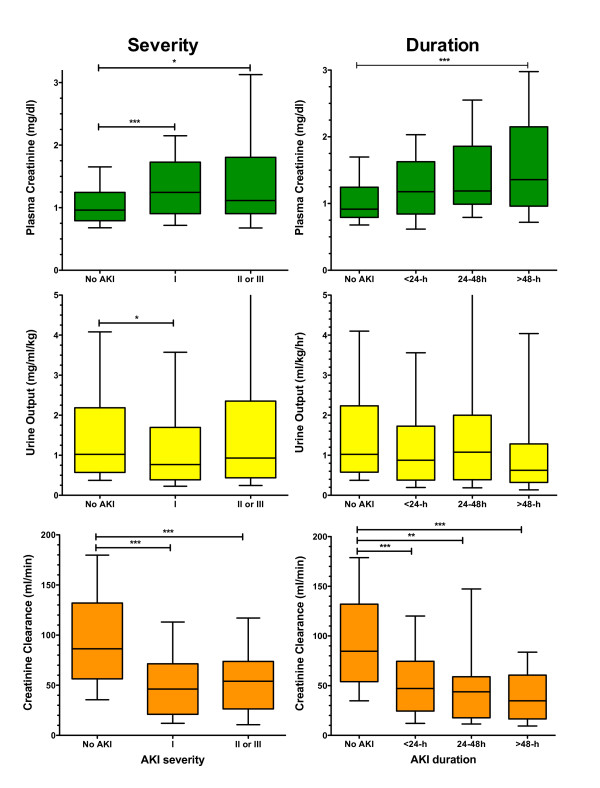
Comparison of on entry plasma creatinine (pCr), urine output (UO), and creatinine clearance (CCl) in the entire cohort with: (i) AKIAKIN severity classes (No AKI, I, II or III) determined from on entry pCr and CCl and UO, (ii) Duration of AKIAKIN. Post-hoc *** P < 0.001, ** P < 0.01, * P < 0.05.